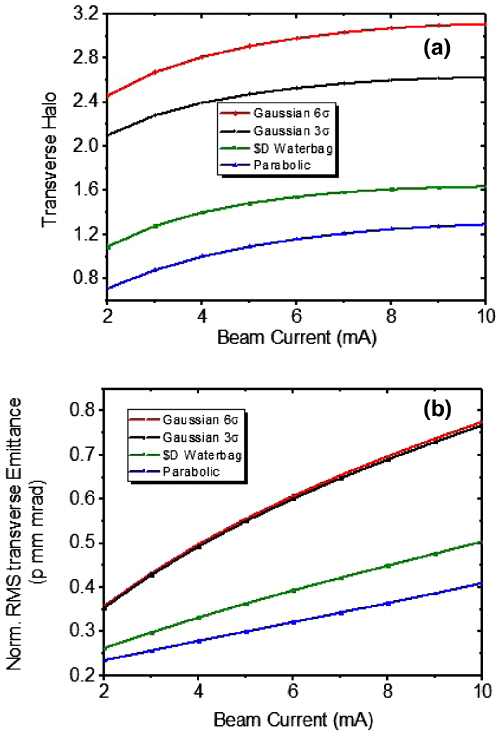
FIG. 3. Evolution of (a) transverse beam halo and (b) transverse rms normalized emittance for 6 σ Gaussian, 3 σ Gaussian, para- bolic, and 4D water bag input distributions, as a function of the beam current at the LEBT